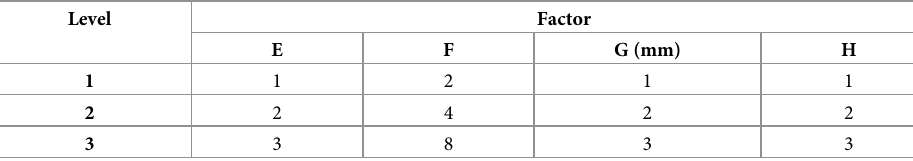
Table 2. Factors and levels for the sieve plate structure and